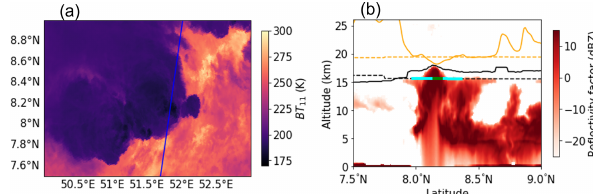
Figure 1. An OT case occurring at night over the Indian Ocean on 1 June 2007. (a) Brightness temperature at 11µm from Aqua MODIS, with a blue line indicating the CloudSat track. (b) Vertical cross section of CloudSat radar reflectivity factor overlapped with MERRA-2 tropopause temperature divided by 10 (orange dashed line), tropopause height (black dashed line), topmost cloud-top height from 2B-CLDCLASS-LIDAR (black solid line), and T b11 divided by 10 (orange solid line). The green line in panel (b) indi- cates the OT region along the CloudSat track, as determined by the method from Marion et al. (2019), and the cyan line indicates the surrounding cirrus